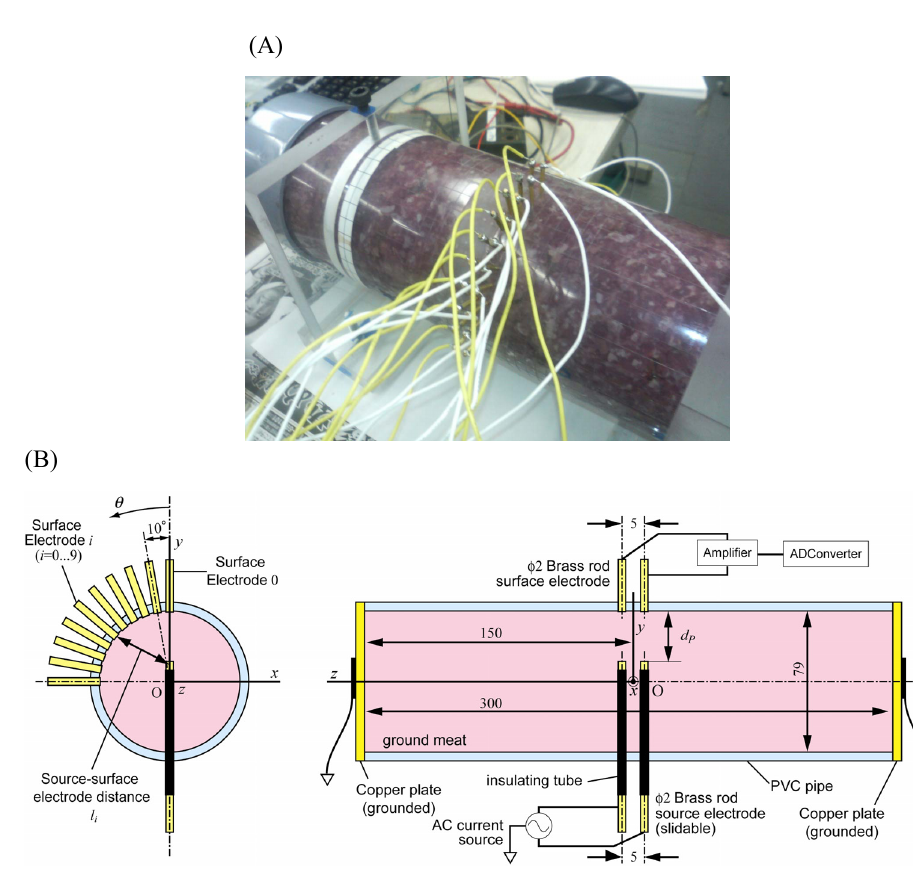
Fig. 2 The phantom-forearm model. (A) The model filled with ground specimens of muscle. Surface electrodes are placed on the model. (B) Schematic layout. The z -axis is assumed to be the center axis, the y -axis is up, and the x -axis is in the lateral direction of the right hand system. The circumferential angle θ around the z -axis is based on the y